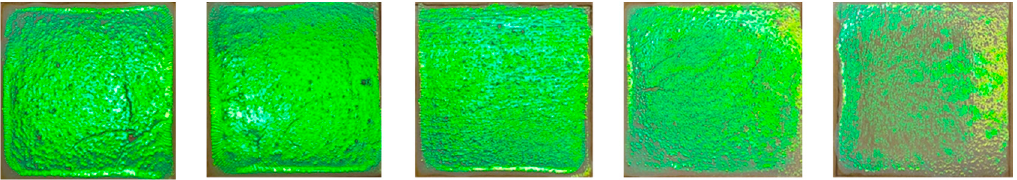
Figure 12. Photographs of the as-prepared coating deposited on the wood surface using 230 nm diameters latex spheres with different droplet amounts.